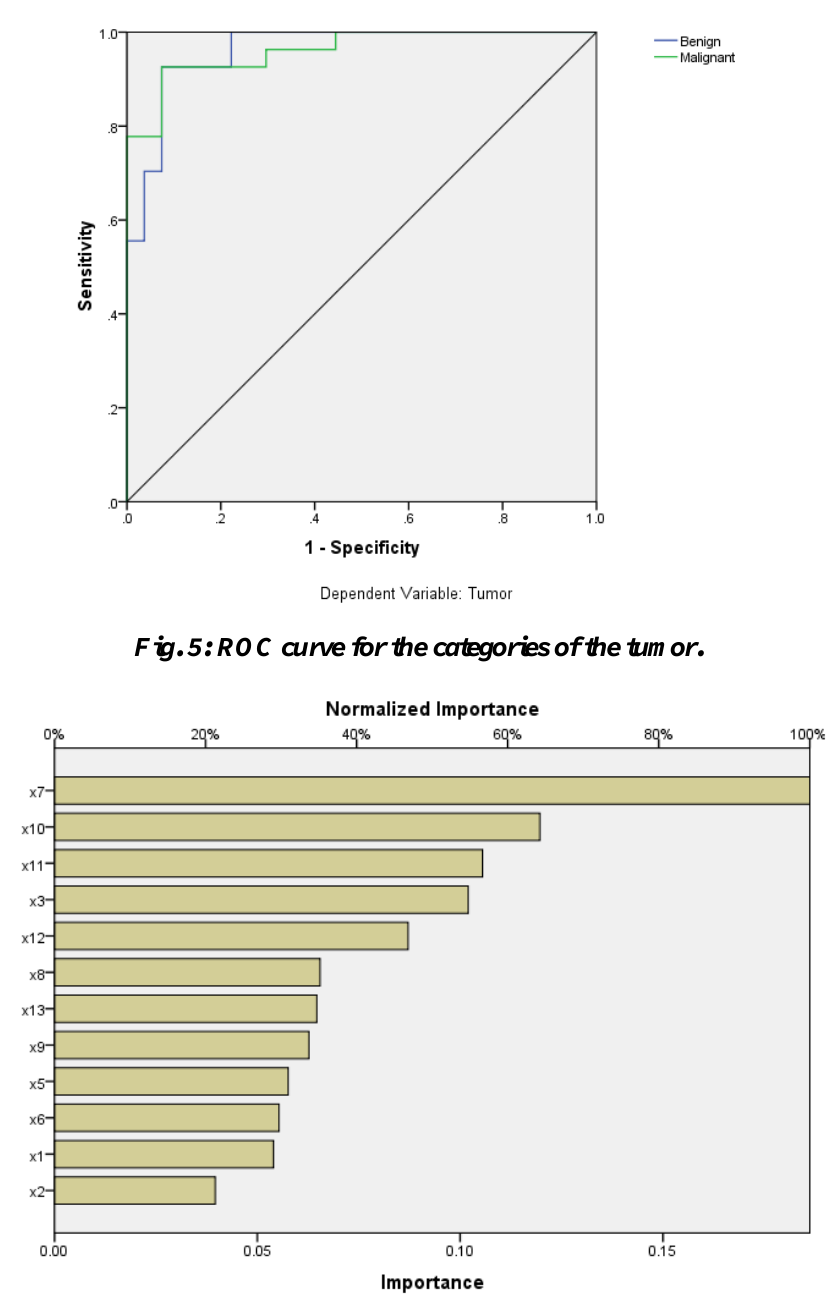
Fig.6: The normalized importance for the input variables used to produce the MLP